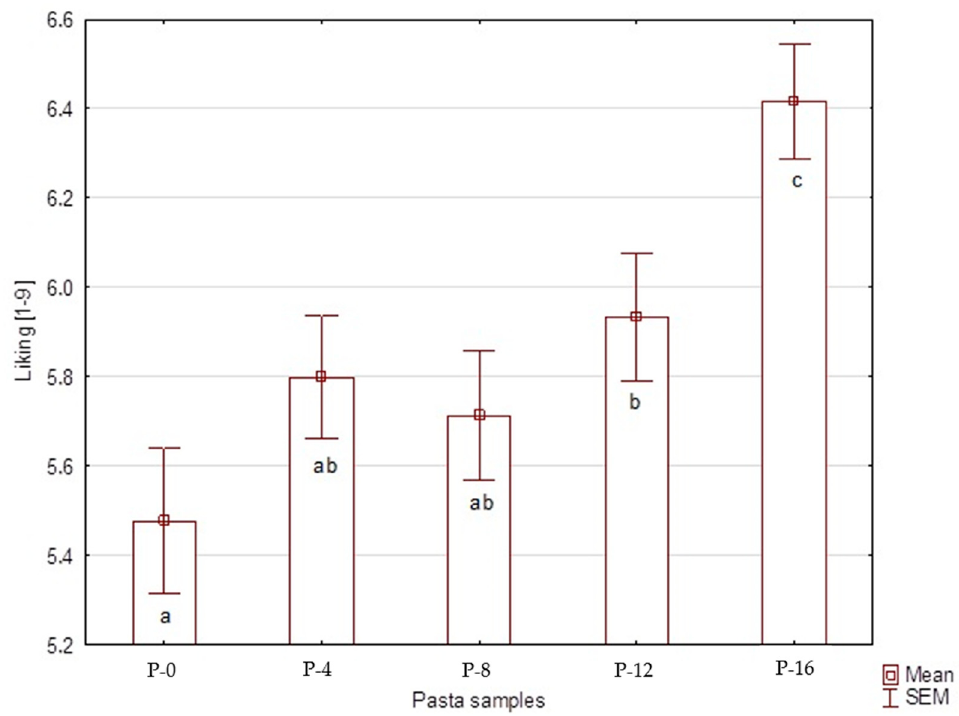
Figure 1. The consumers’ liking of the cooked pasta samples ( n = 150); P-0—control sample, P-4, P-8, P-12, and P-16—4–16% oat β -glucan fiber powder addition; abc means with various letters, they